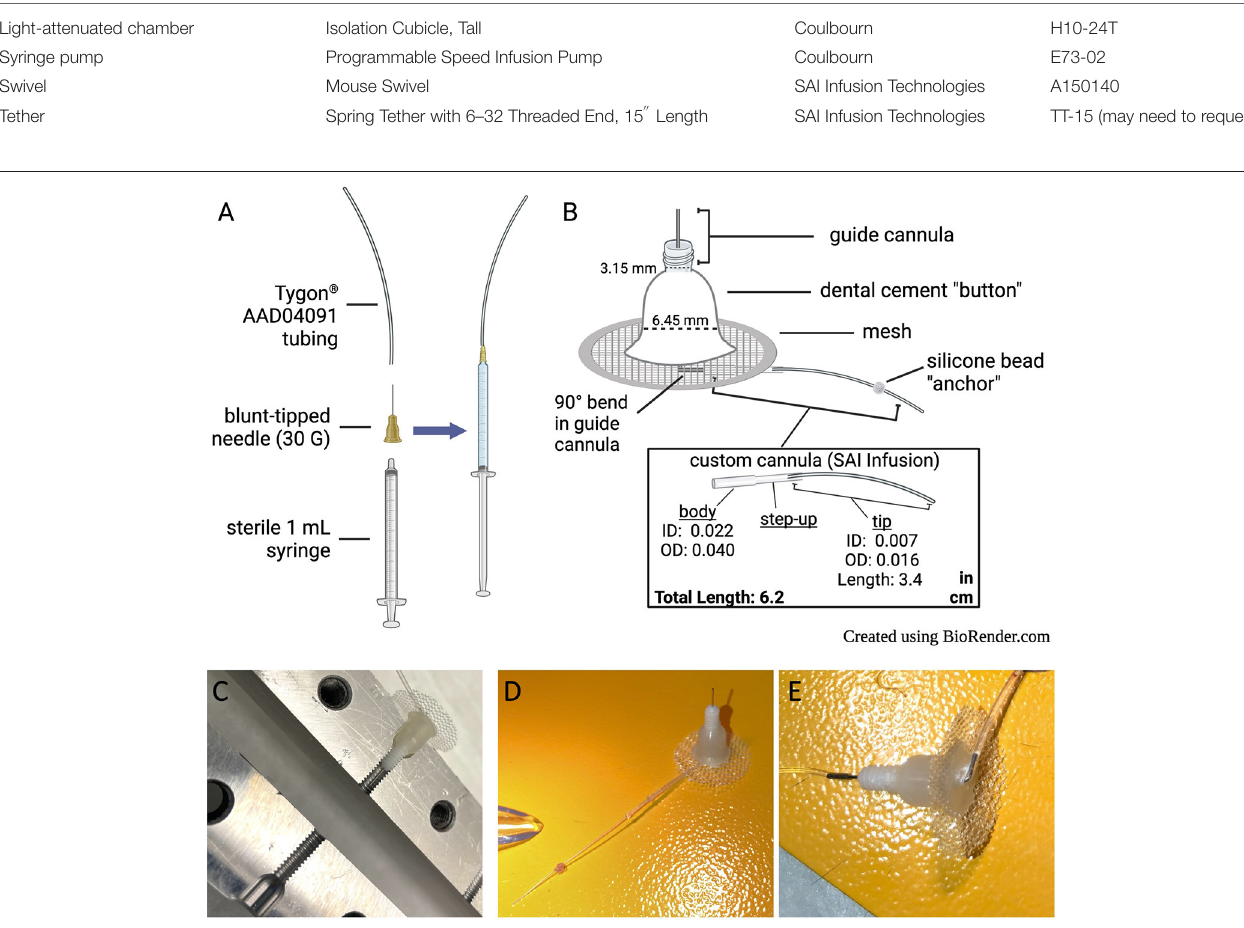
FIGURE 1 | Catheter design and care. (A) Set-up for attaching tubing to syringe for surgical drug delivery, catheter flushing, and checking catheter patency. (B) Descriptions of catheter components. (C) Custom acrylic base mold, in open position, with completed catheter in place to demonstrate mold placement. (D) Picture of assembled catheter. (E) Underside of assembled